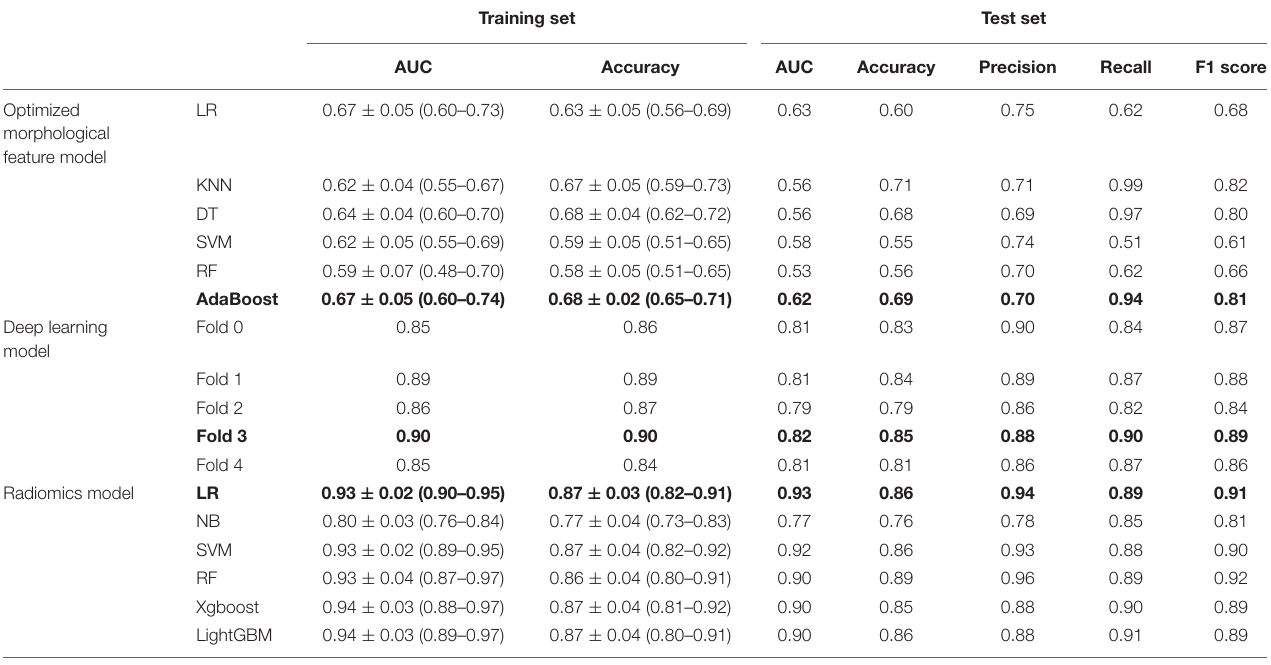
TABLE 4 | The predictive performance of multimodal models in the training set and test set.